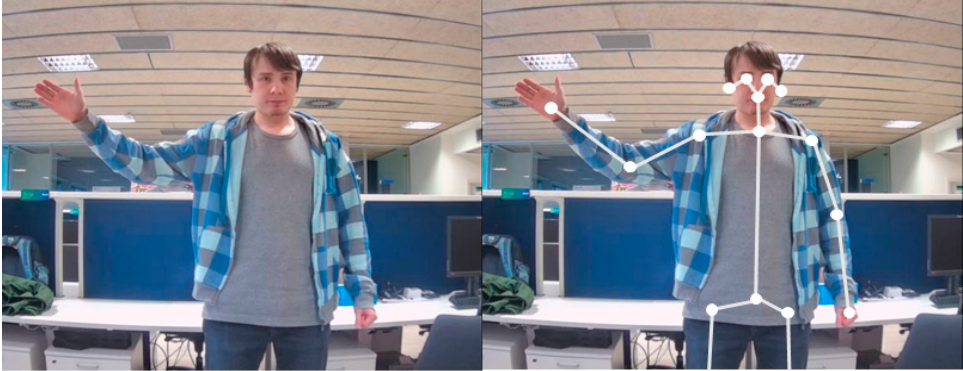
Figure 4. Example of body tracking